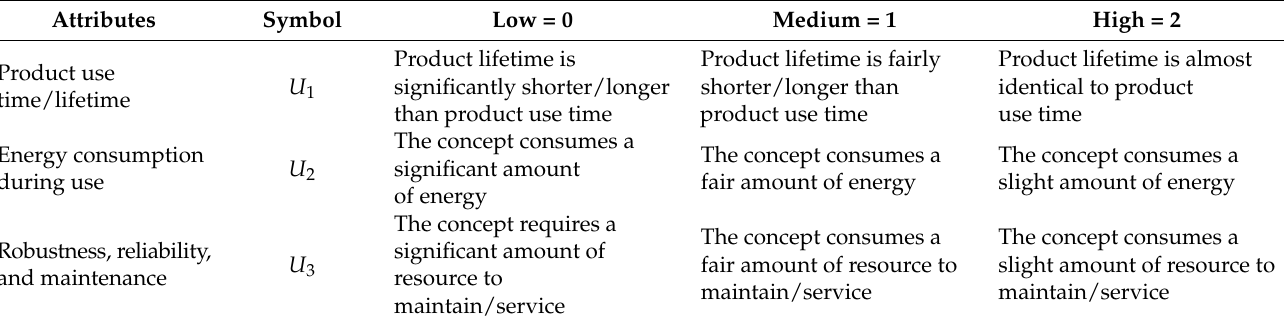
Table 5. Attributes for measuring concept use